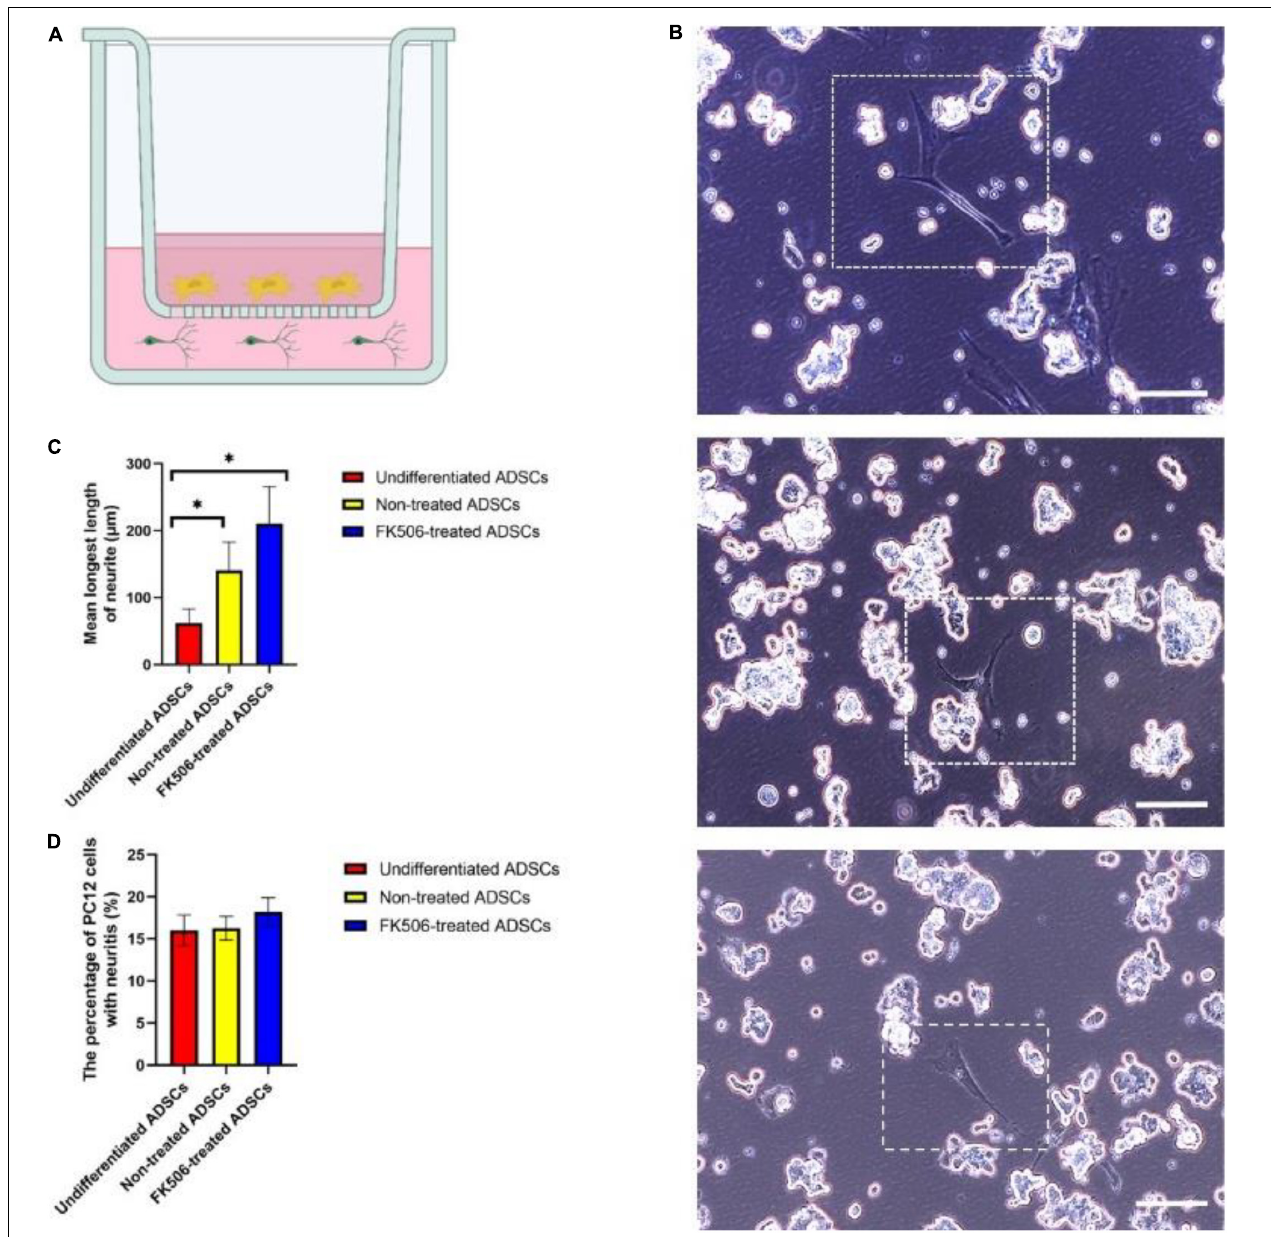
FIGURE 4 | (A) Schematic diagram of the ADSC and PC12 cells indirect co-culture system. ADSCs were seeded in the upper chamber while PC12 cells were seeded in the lower chamber. ADSCs could not migrate across the porous polyester membrane but the neurotrophic factors secreted by ADSCs could pass freely through the inserts. (B) Representative images of PC12 cells co-cultured with ADSCs after 72 h. From the top to the bottom, PC12 cells were co-cultured with FK506-treated ADSCs, non-treated ADSCs and undifferentiated ADSCs. Scale bar = 100 µ m. (C,D) The percentage of PC12 cells with neuritis and the average length of longest neurite were calculated on PC12 cells co-cultured with undifferentiated ADSCs, non-treated ADSCs and FK506-treated ADSCs. Data are resented as mean ± SD. ∗ P < 0.05 Data from differentiated ADSCs was significantly different compared with undifferentiated